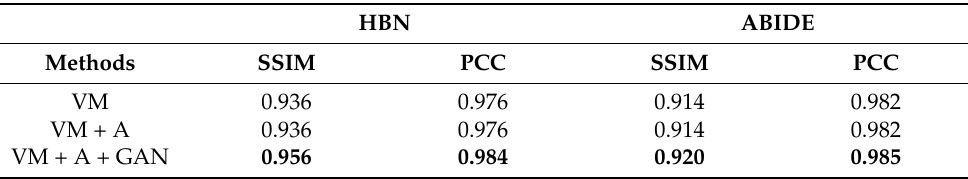
Table 4. SSIM and PCC metrics for deep-learning-based registration methods. Bold numbers indicate the best